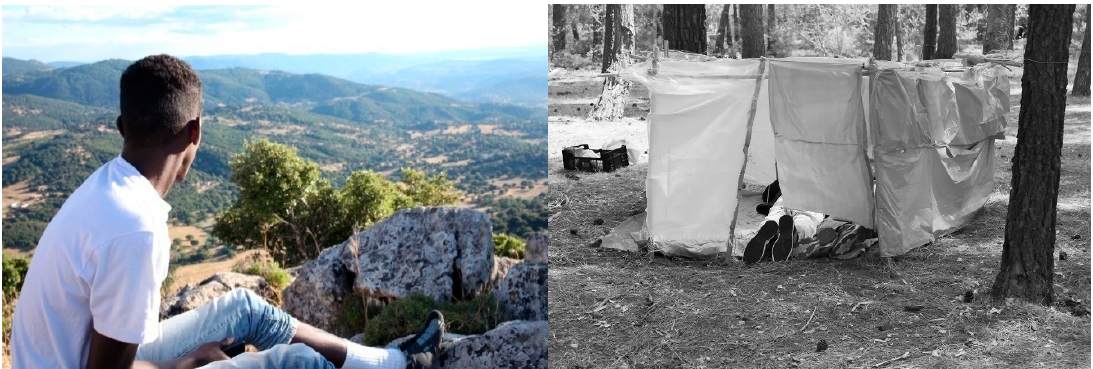
Figure 3. Ali (Somalia) observes the Sardinian landscape, remembering his faraway land. A frame of On The Same Boat , a hut in the woods is built, an emotional representation of a journey.